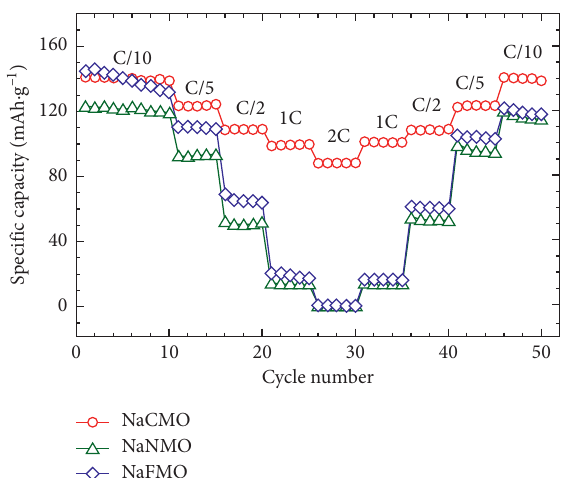
Figure 6: Rate capability performances of NaCMO, NaNMO, and NaFMO